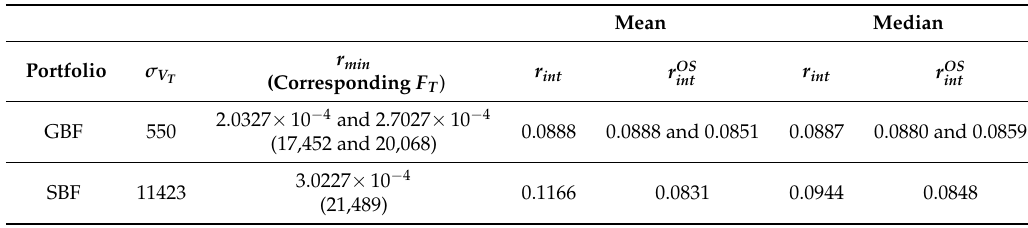
Figure 2. Volatility of the value of the pension funds at maturity under optimal strategy (OS) for various r min ( σ = 0.025). Table 1. Internal return of Domestic Government Based Fund(GBF), Stock Based Fund(SBF) and Equivalent Optimal Strategy(OS) based on mean and median final value of the pension funds at maturity (fixed r min and σ =